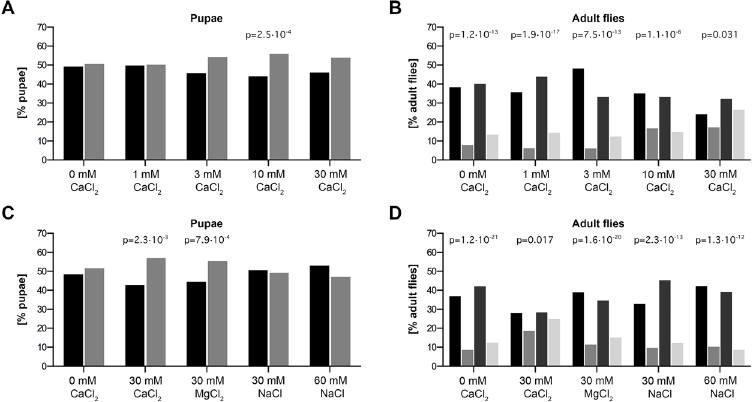
Fig 2. Usp2 clock output effector status and role in bodily Ca 2+ homeostasis are conserved across evolution. d Usp2 -kd and control siblings were bred and raised on the indicated dietary conditions. Pupal cases and adult flies were counted and Mendelian proportions were calculated on the following numbers of pupal cases / adult flies, respectively: 0 mM CaCl 2 : 611 / 266, 30 mM CaCl 2 : 468 / 236, 30 mM MgCl 2 : 924 /